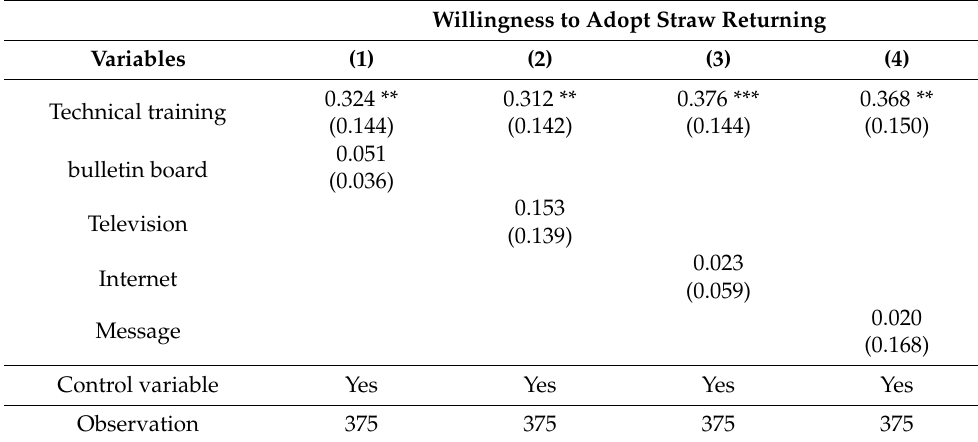
Table 5. Impact of self-learning on farmers’ willingness to adopt straw